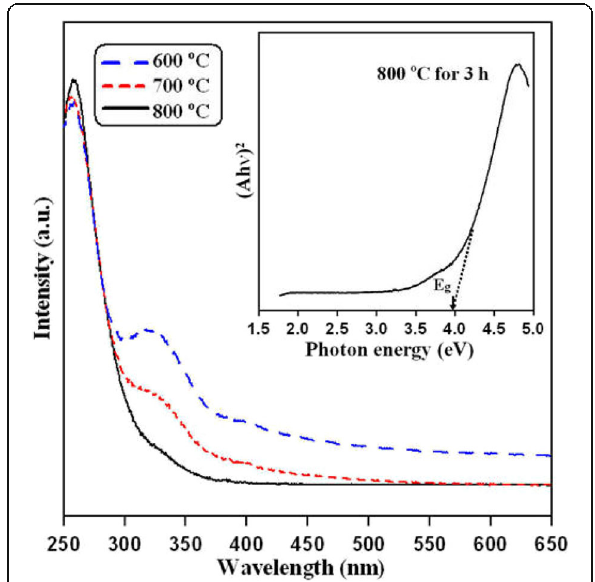
Fig. 8 Absorption spectra of the La 3 Ga 5.5 Nb 0.5 O 14 powders annealed at 600 – 800 °C for 3 h measured at room temperature. The inset is the behavior of optical absorption as the function of photon energy for La 3 Ga 5.5 Nb 0.5 O 14 macroporous at 800